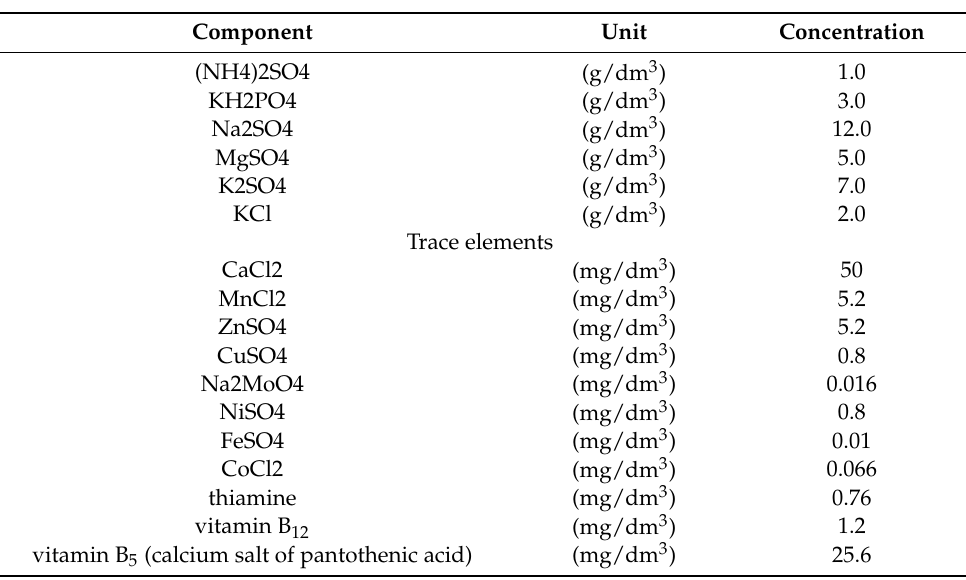
Table 2. Characteristics of artificial